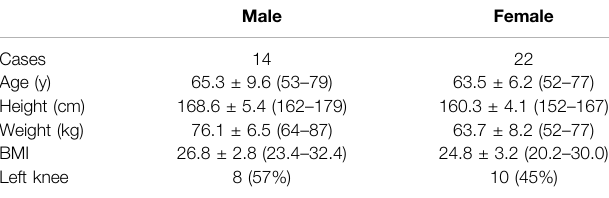
TABLE 2 | General information of in vivo test